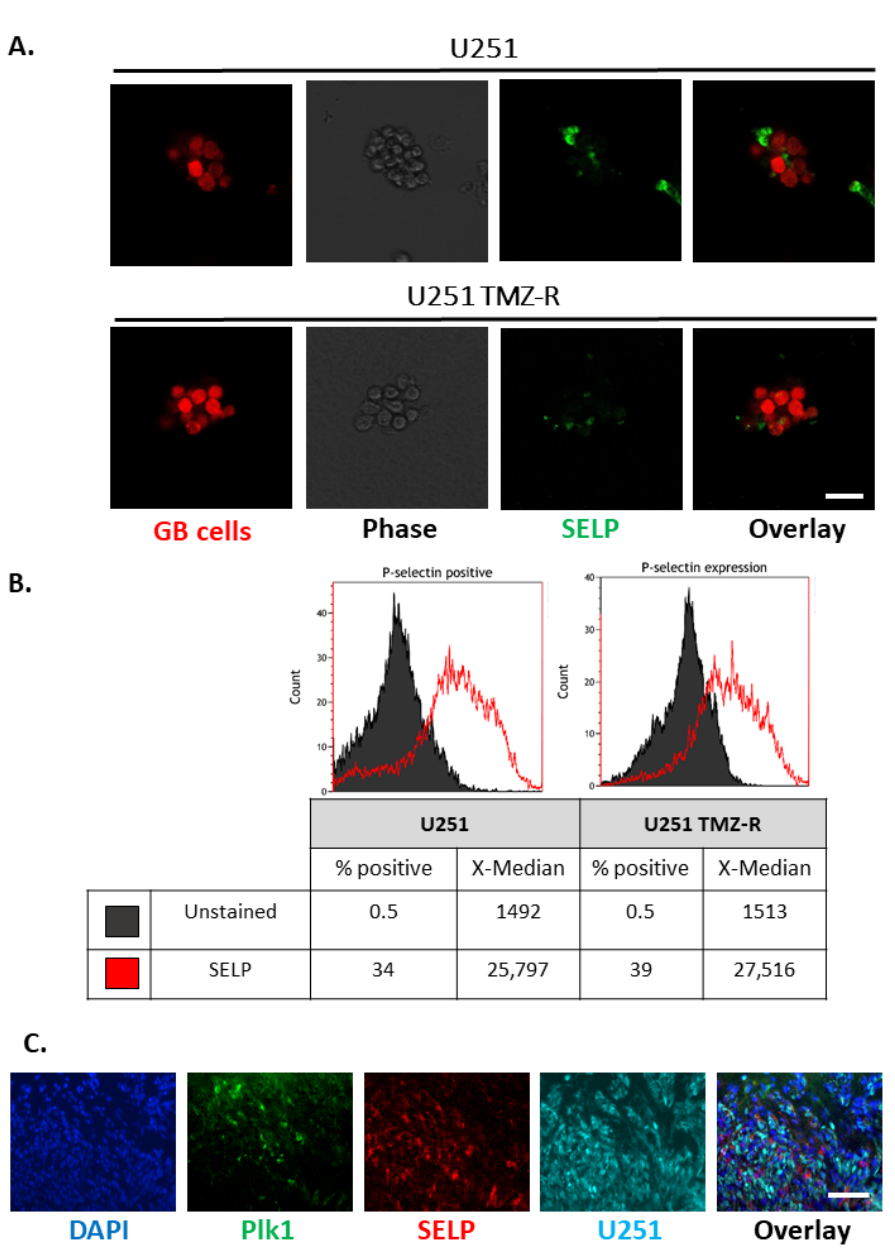
Figure 4. SELP expression on U251 and U251 TMZ-R 3D spheroids. ( A ) Imaged by confocal microscopy (scale = 20 µm) and ( B ) analyzed by fluorescence activated cell sorting (FACS). ( C ) SELP expression on slices of U251 intracranial tumors and co-localization with Plk1 (scale = 100 µm).